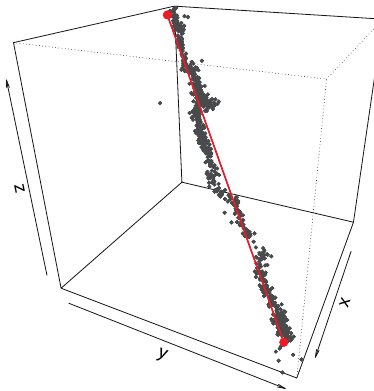
Figure 3. Fitted 3D displacement vector (red line with start and end points, first principle component) based on daily ATTS